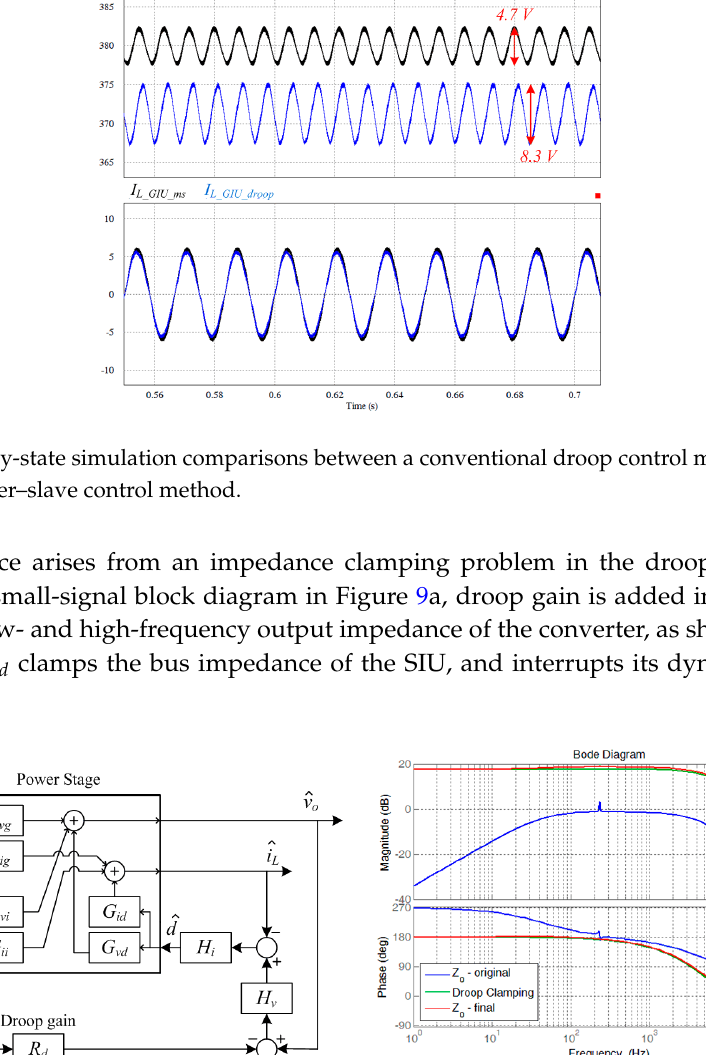
Figure 9. ( a ) Small ‐ signal block diagram of the storage interface unit (SIU) and ( b ) the output impedance bode diagram of the SIU in the droop control system.